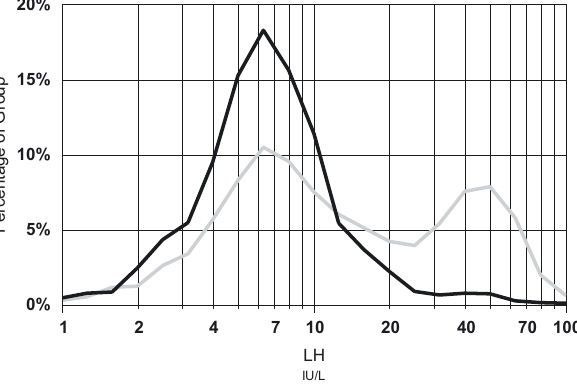
Figure 1: Distribution of luteinising hormone (LH) results for 9,684 women aged 40 – 45 years, with the day of their period indicated on the request form (black line) compared to distribution of 4,295 women with clinical notes indicating flushing or possible menopause (grey